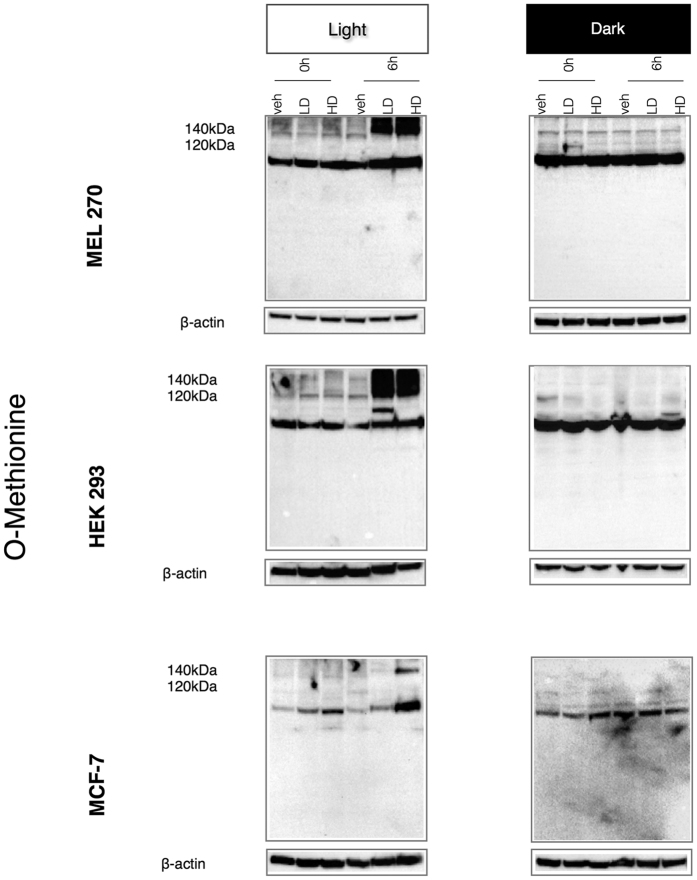
Increased expression of O-methionine in light treated cells with VP.O-Met Western-blot of protein extracts from cells treated with vehicle (veh.), low dose (LD, 1.25 μg/ml) or high dose (HD, 7.5 μg/ml) of Verteporfin (VP) for 0 and 6 hours. Right column demonstrates cells that kept in absolute darkness during all steps (treatment, lysis and electrophoresis). Left column demonstrates cells that were kept in darkness only for the duration of treatment with subsequent steps of cell lysis and electrophoresis in ambient light. When all steps were performed in light we see an increase O-MET expression in a pattern that coincides to the one observed in HMWC formation of the aforementioned proteins. In absolute darkness, the increase in O-Met reactivity was abrogated.